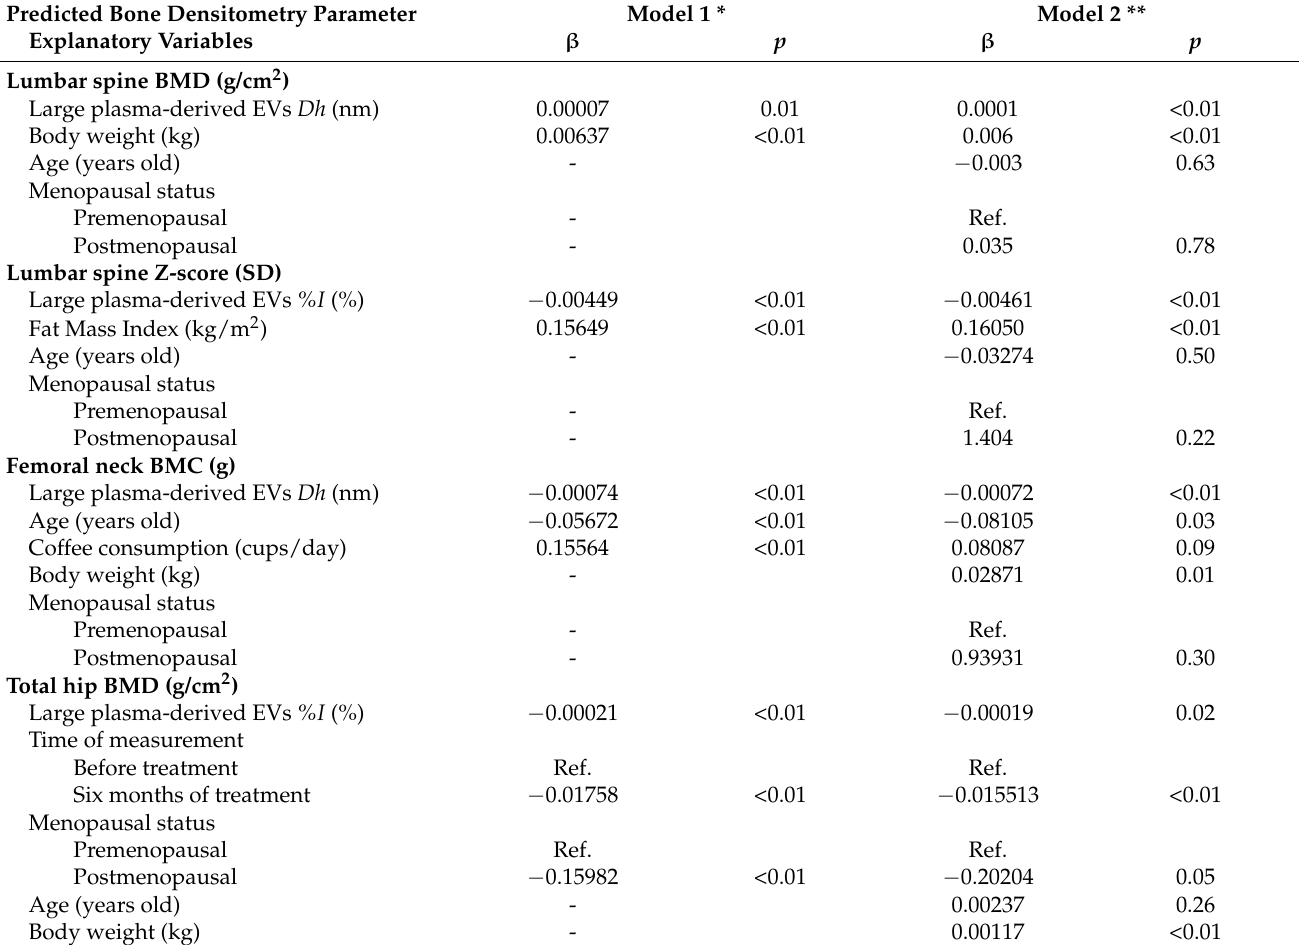
Table 3. Mixed-effect linear regression models for prediction of bone densitometry parameters in breast cancer patients receiving a nutritional intervention during the first six months of antineoplastic